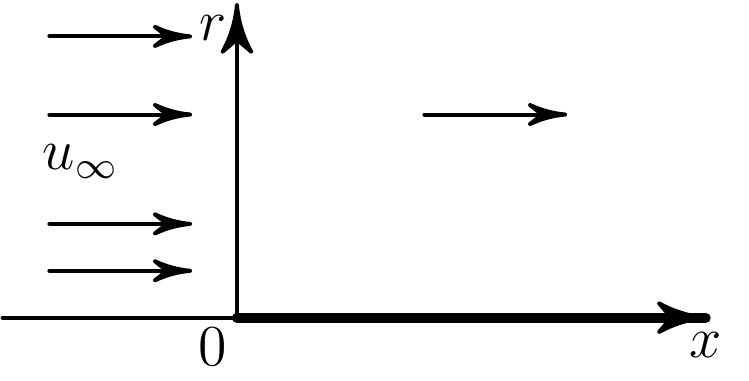
Figure 1. Streamline of a needle by the filling